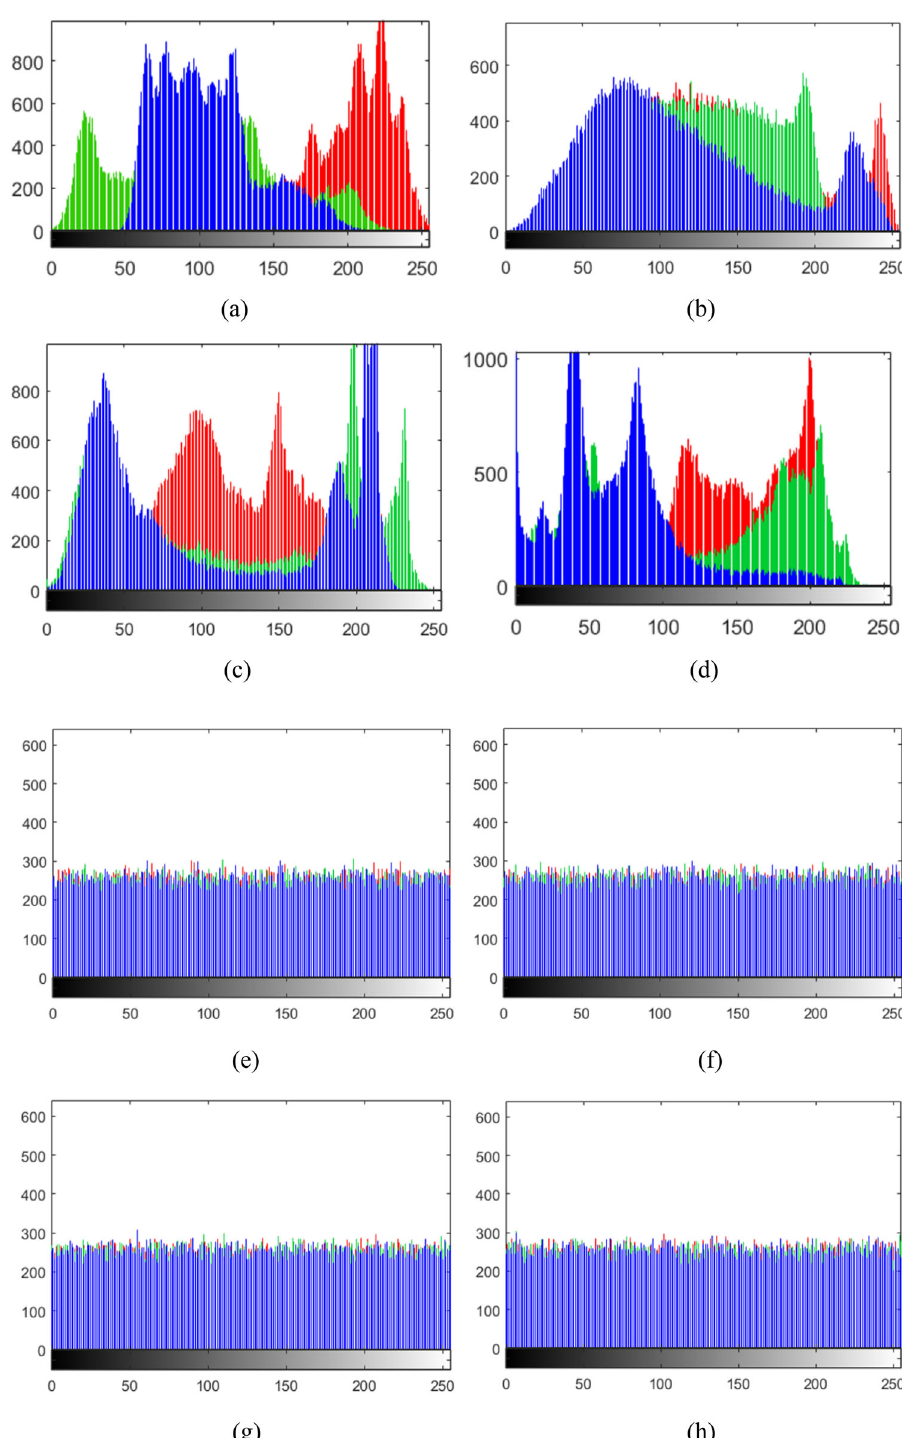
Fig. 10 Histograms of plaintext and ciphertext